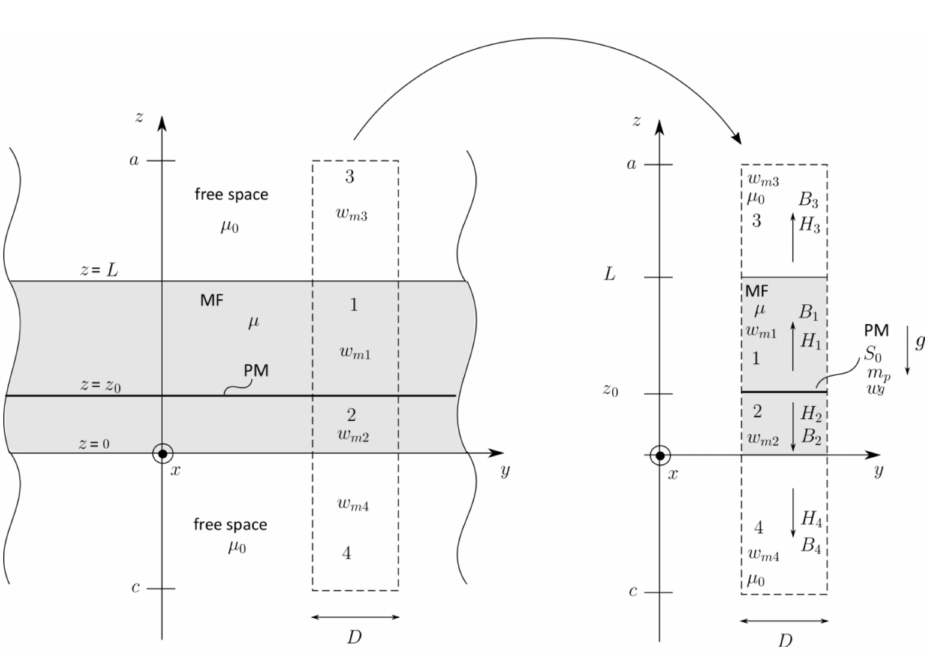
Figure 7. A column of the simplified analytical model is considered in a qualitative analysis of a stable levitation